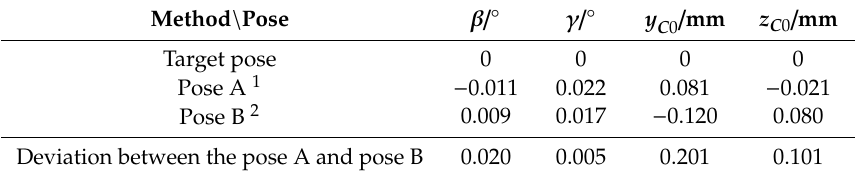
Table 4. Pose parameters before the adjustment and after the